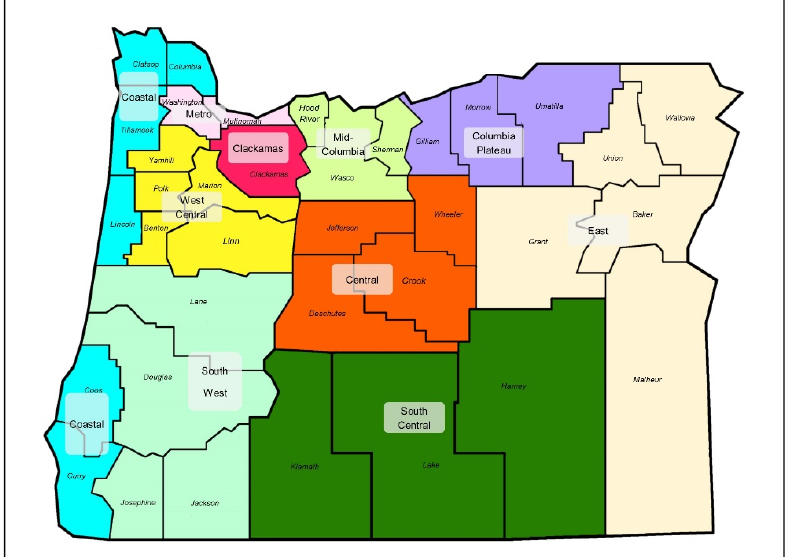
Figure 1. Oregon State University Extension Regions (as of